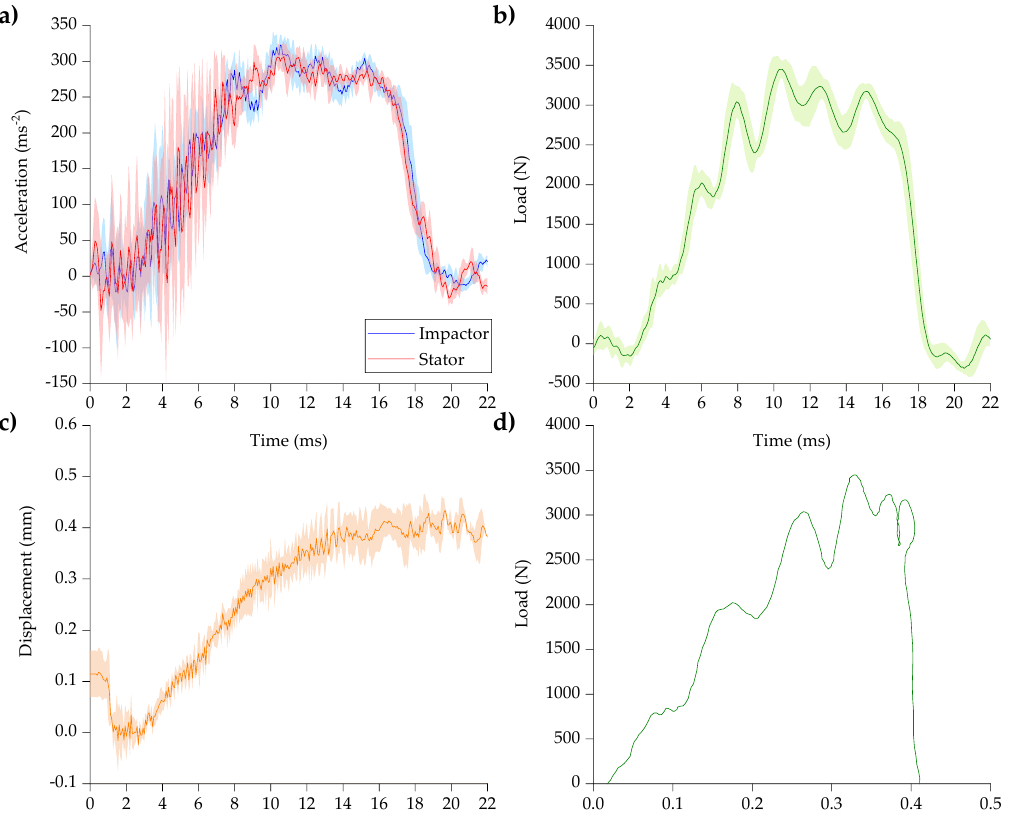
Figure 6. Compression impulse of inert pouch cells: ( a ) impactor and stator acceleration, ( b ) compressive load measured by the load cells, ( c ) displacement from high speed camera, ( d ) load- displacement curve.